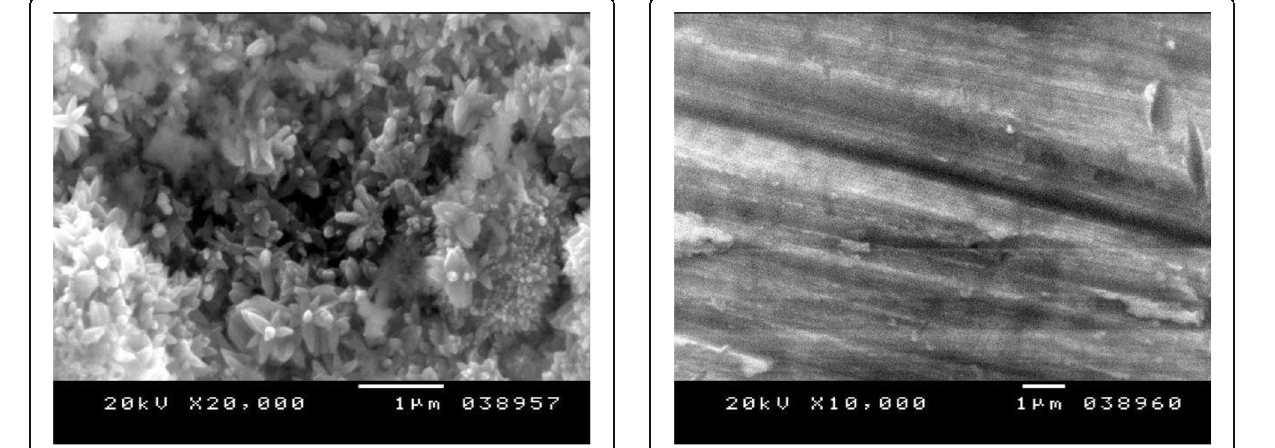
Fig. 6 Scanning electron microphotograph of Cp titanium specimen coated with HA-Zn at ×20,000